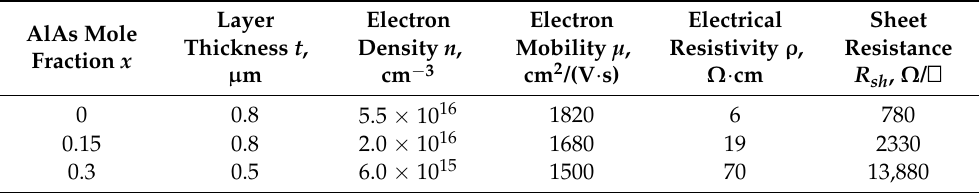
Table 1. Parameters of the epitaxially grown Al x Ga 1- x As layers.